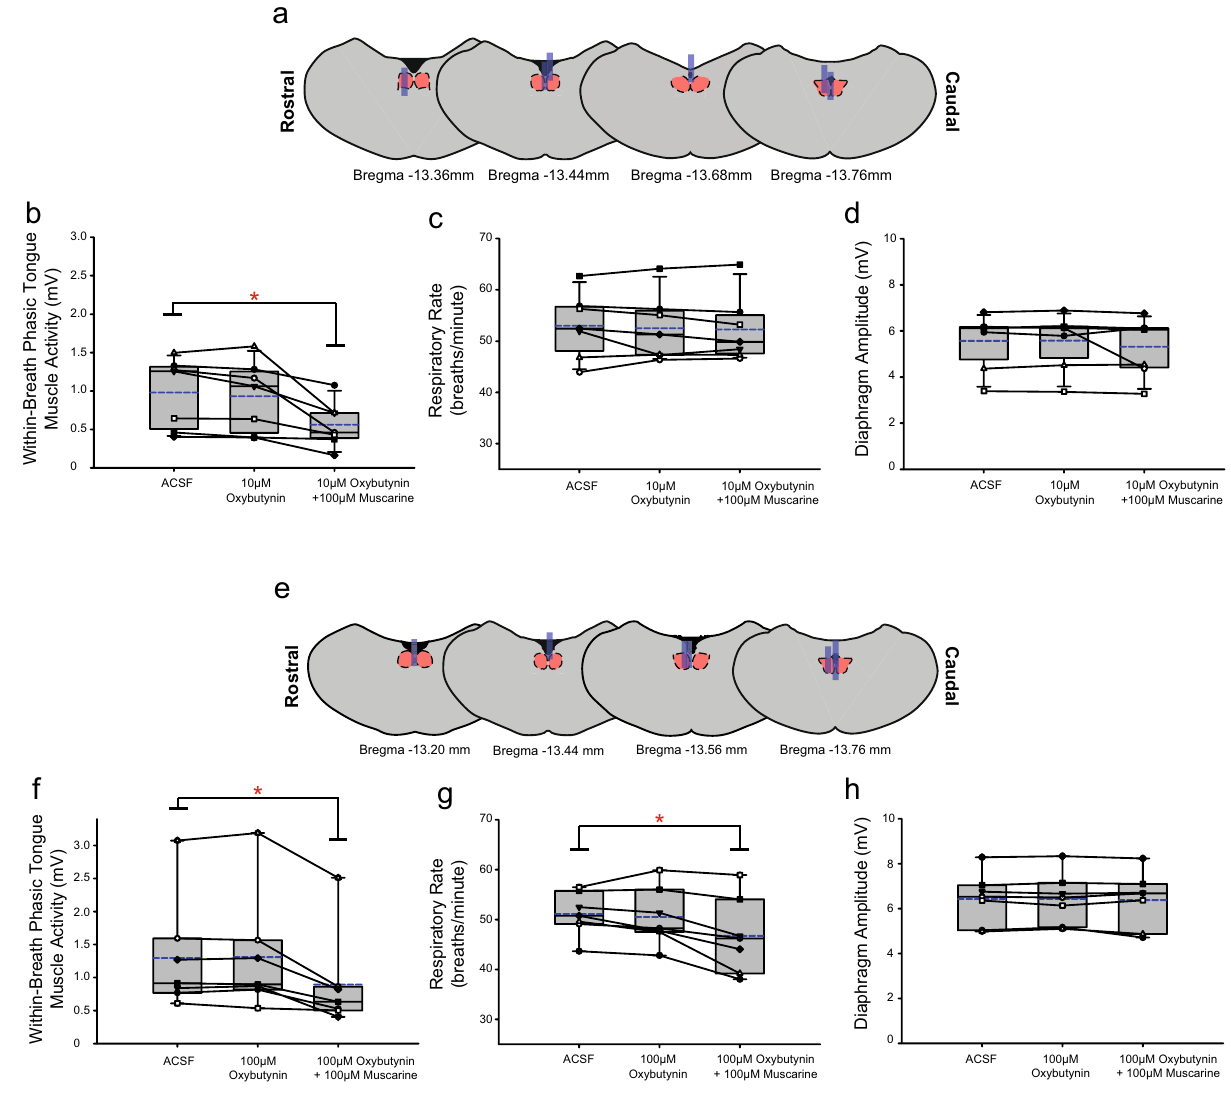
Figure 13. Group data from Protocol 3.2c : Microperfusion of oxybutynin into the HMN with and without co-application of muscarine (top panels: 10 µM, n = 7; bottom panels: 100 µM, n = 7). Schematic representations of coronal sections of medulla illustrating the distribution of probe sites across all experiments ( a , e ). Drawn to scale, the blue rectangles represent reconstruction of the sites of the microdialysis probes; overlap obscures some of the individual probe sites. Box and whisker plots show individual and group data (median [dashed line], mean [solid line] and 25th and 75th percentiles) for within-breath phasic tongue muscle activity ( b , f ), respiratory rate ( c , g ), and diaphragm amplitude ( d , h ). Each animal is indicated by a different symbol. *, indicates p < 0.05 compared to baseline ACSF